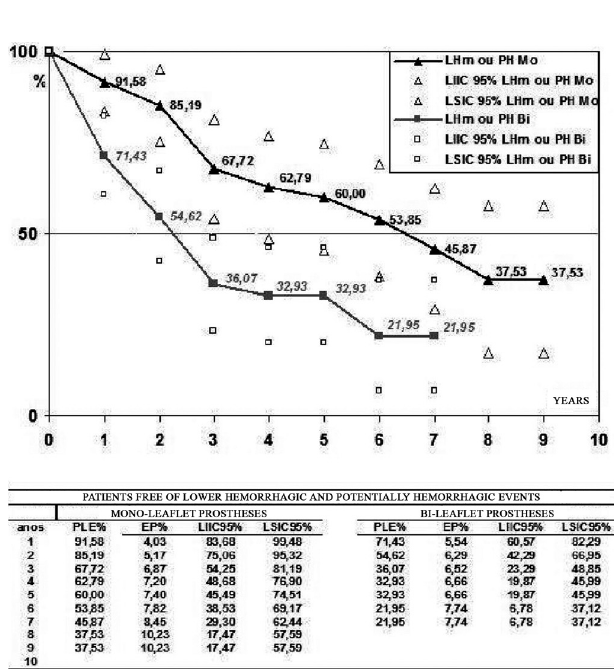
Fig. 7 - Curves and actuarial data showing the percentage of patients free of minor bleeding or potentially bleeding events mBE or PB (ordinate) with time - years (abscissa) for both types of prostheses studied.